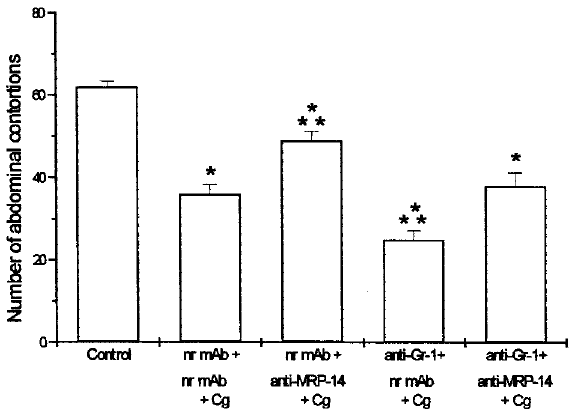
FIG. 5. Effect of simultaneous treatment of the animals with anti-granulocyte (anti-Gr-1) and anti-MRP-14 mAbs on anti- nociception induced by carrageenan (Cg) in animals sub- mitted to the writhing test. ThemAb anti-Gr-1 was injected 36h before the irritant and the anti-MRP-14 was injected 5min before the injection of Cg. The nociceptive test was applied 4h after Cg injection. Animals injected with non relatedmAbs (nrmAbs) + Cg, nrmAb + anti-MRP-14 + Cg or nrmAb + anti-Gr-1 + Cg were also evaluated. Controls were injected with acetic acid. Values represent the mean ±S.E.M. of 8–16 animals for each group. * p < 0.05 in comparison with values obtained in control animals. ** p < 0.05 in comparison with animals treated with nrmAbs + Cg.